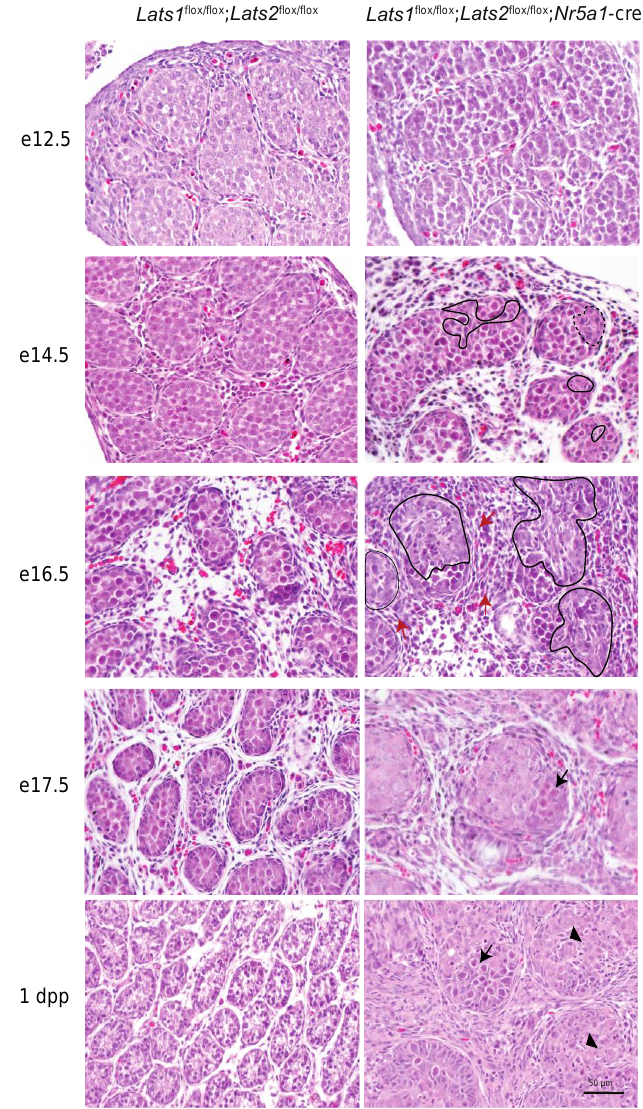
Figure 2. Progressive testicular dysgenesis in the Lats1 flox/flox ; Lats2 flox/flox ; Nr5a1 -cre mice. Photomicrographs comparing testis histology of Lats1 flox/flox ; Lats2 flox/flox ; Nr5a1 -cre with that of Lats1 flox/flox ; Lats2 flox/flox controls during development. Dashed lines = testis cords dysgenesis, black arrow = germ cells, red arrow = interstitial spindle-shaped cells, arrowhead = spindle-shaped cells in the testis cords. Scale bar (lower right) is valid for all images. Hematoxylin and eosin stain.